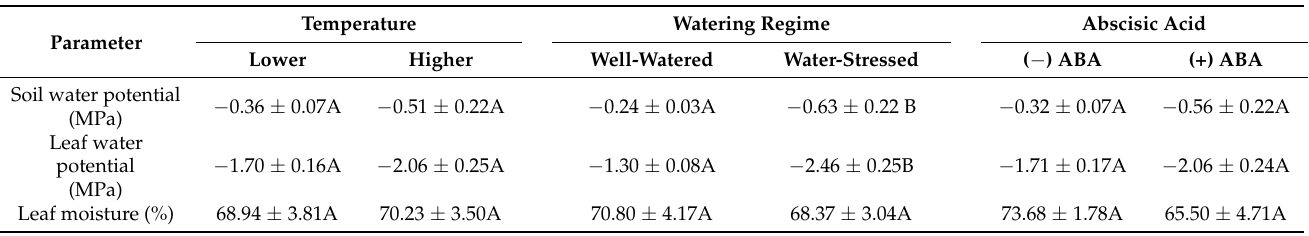
Table 16. Effects of temperature, watering regime, and abscisic acid on water potential and moisture of tomato